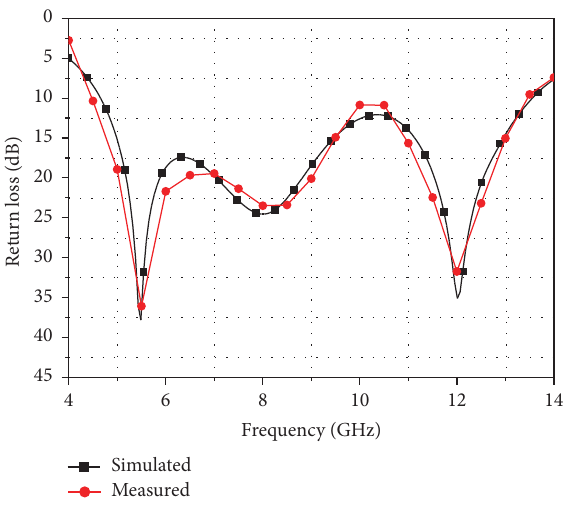
Figure 13: Simulated and measured return loss for the proposed defected substrate wideband